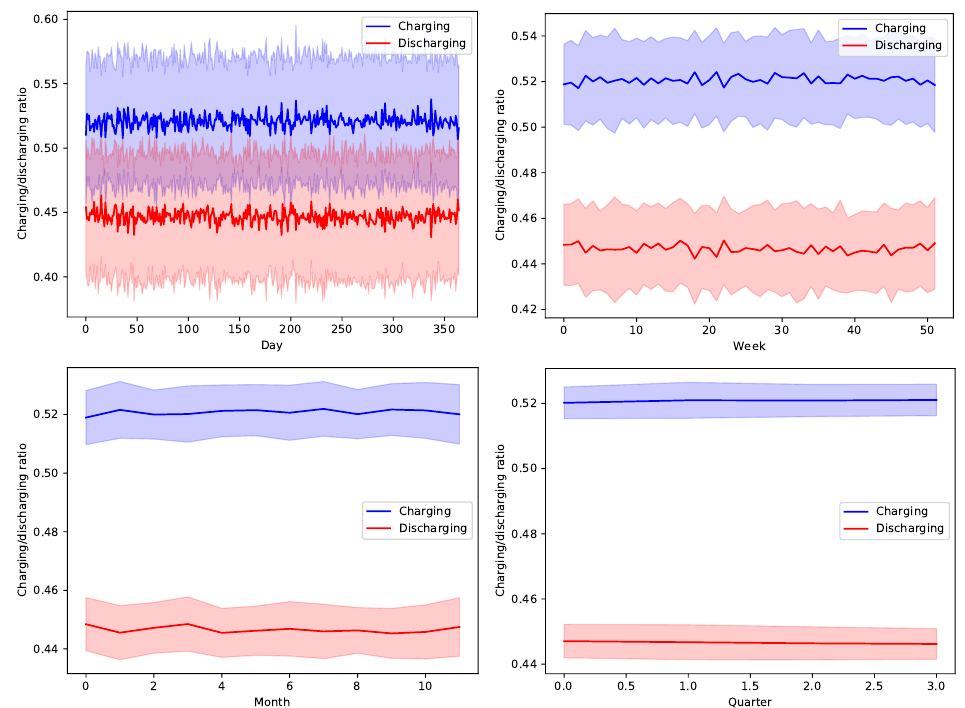
Figure 13. The average temporal charging and discharging ratios of EVs according to the greedy policy with a global certainty level U 10 .